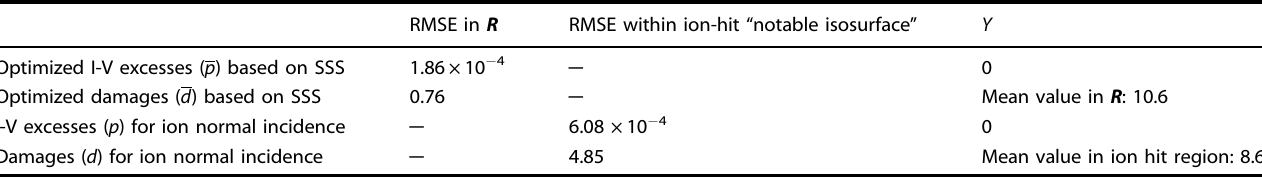
The RMSE estimations (unit in # nm − 1 ion − 1 ) from the I-V excesses and damages in the designated macroscopic region R based on SSS framework and the ion hit “ notable isosurface ” with ion normal incidence plotted in Fig. 5. The errors for both I-V excesses and damages are signi fi cantly reduced through SSS. tilted by θ 0 ¼ 0 : 12, and being fast rotated around axis identi fi ed With the optimized surface inclination angle and axis of sample rotation, the average I-V imbalance (calculated according to Eq. 14 with d ϕ = π /180), as the bold black lines shown in Fig. 5a, is signi fi cantly minimized in the certain designated macroscopic region R (1.2 μ m in z , millimeters in x and y ) with a quasi- fl at average damage/dose distribution (bold blue lines in Fig. 5b) in the same region based on SSS. The ion momentum mixing expressed by the f pro fi le in 3D and one-linear forms in this case study are plotted in Fig. 5c, d, showing that all the ions participate in the average for this design. Here, the root-mean-square errors (RMSE) of the I-V excess p ( z ) and damage d ( z ) concentration are tallied to clarify the ef fi ciency of SSS on minimization of I-V imbalance and damage non- uniformity: